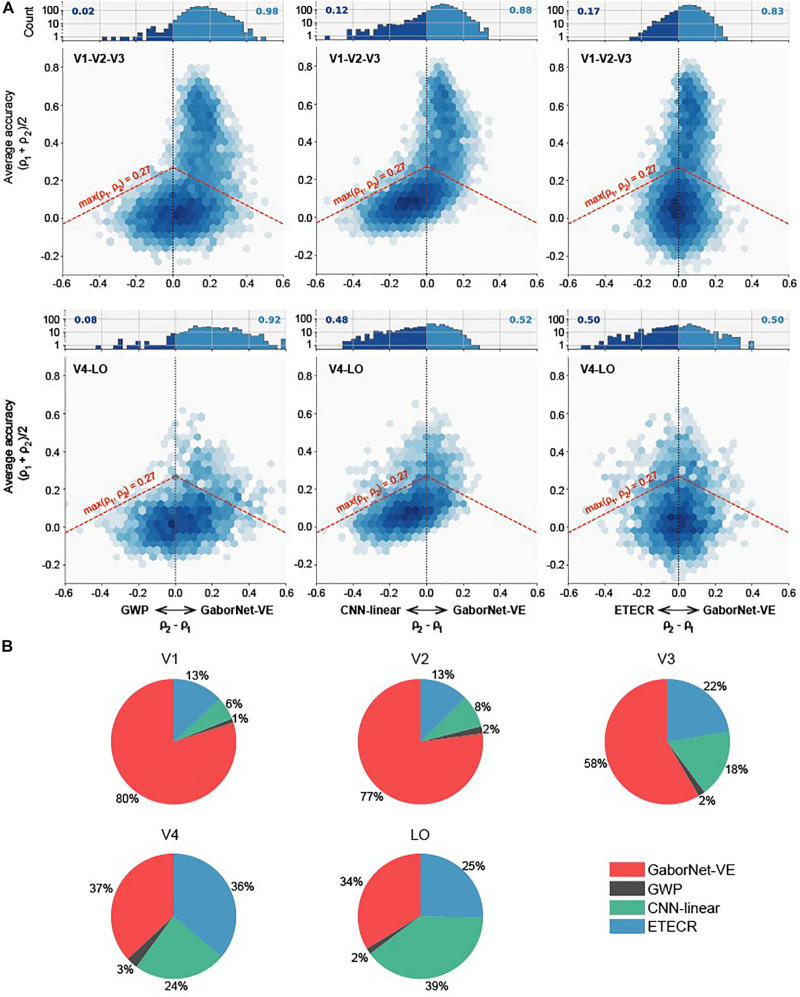
Comparisons of GaborNet-VE, GWP, CNN-linear, and ETECR models by sorting voxels in descending order of prediction accuracy. Only accurately predicted voxels are plotted. Red, gray, green, and blue curves represent GaborNet-VE, GWP, CNN-linear, and ETECR models, respectively.